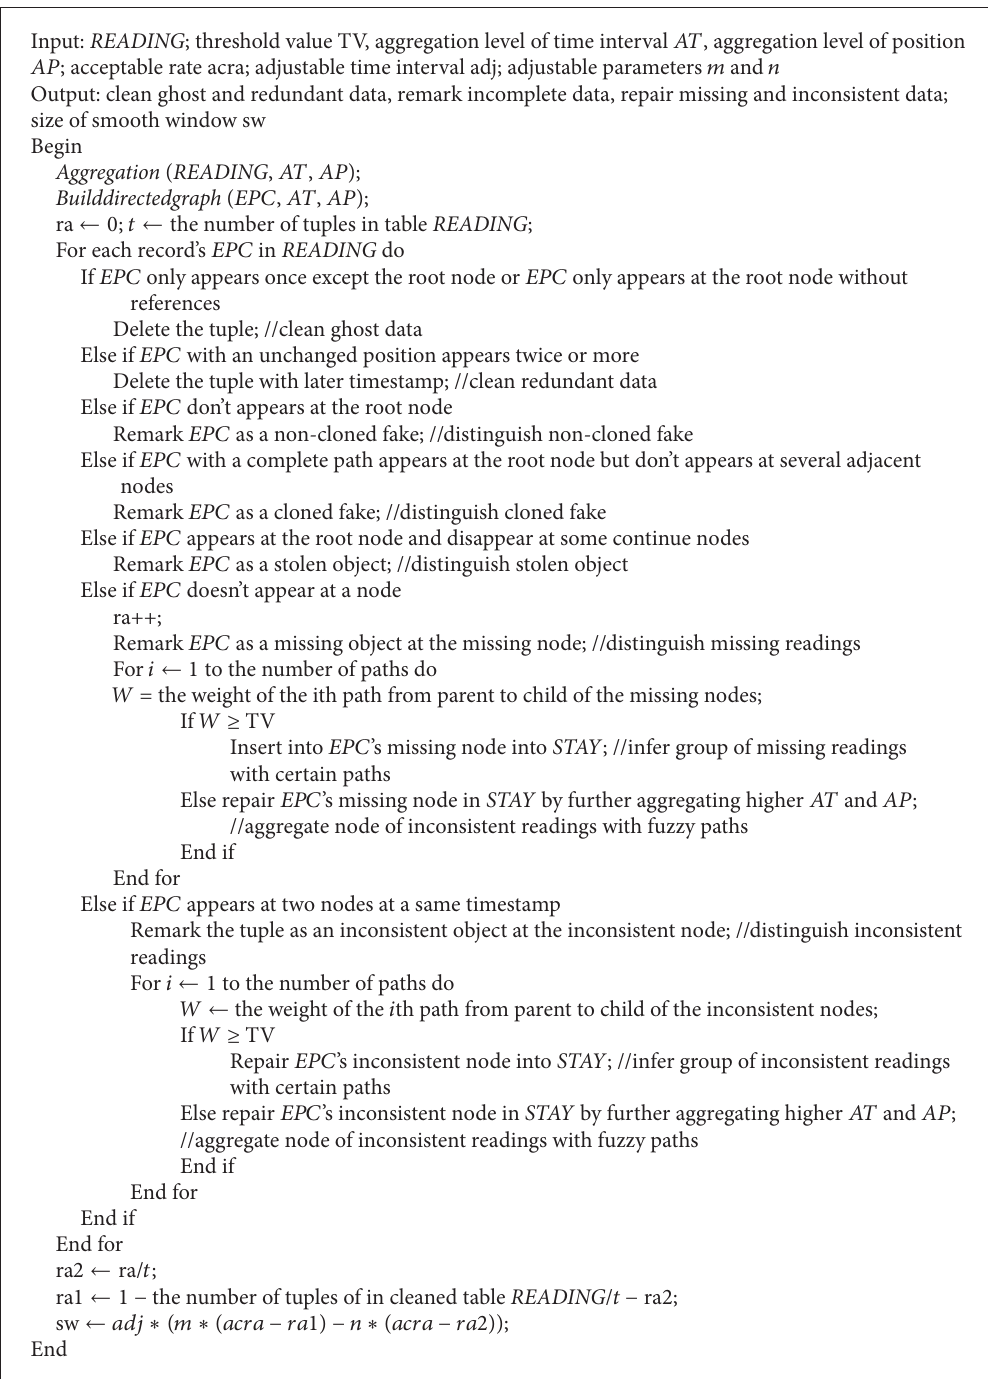
Algorithm 1: //Processing